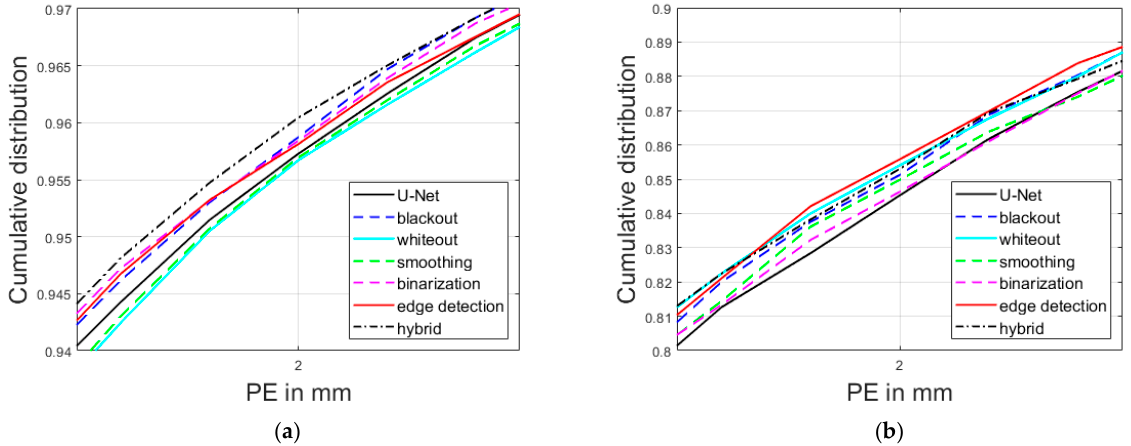
Figure 4. MRE curves according to different perturbations. ( a ) Digital Hand Atlas dataset (U-Net). ( b ) ISBI 2015 test1 dataset (U-Net).